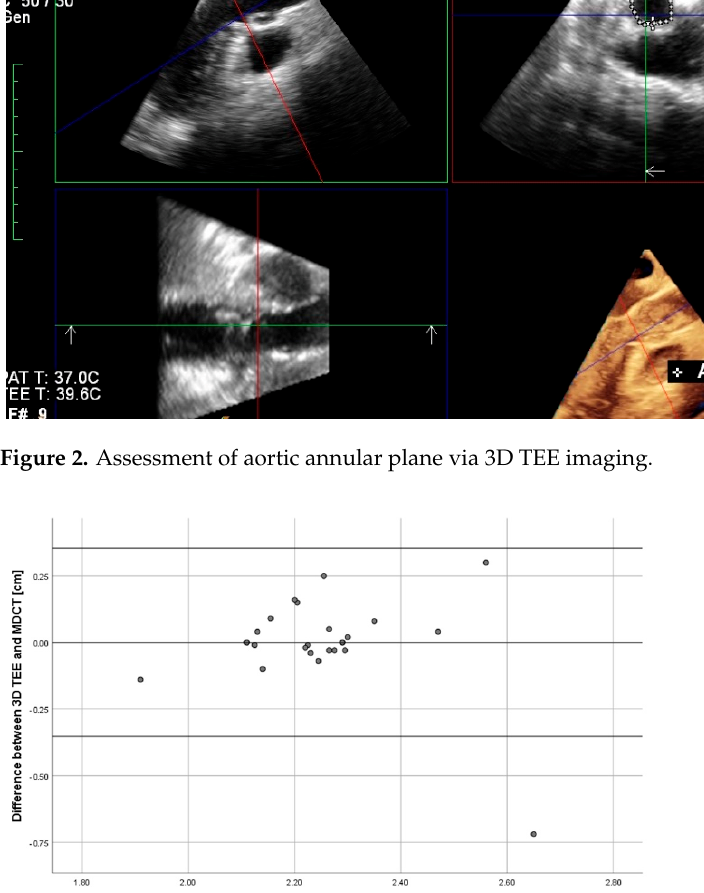
Figure 2. Assessment of aortic annular plane via 3D TEE imaging.